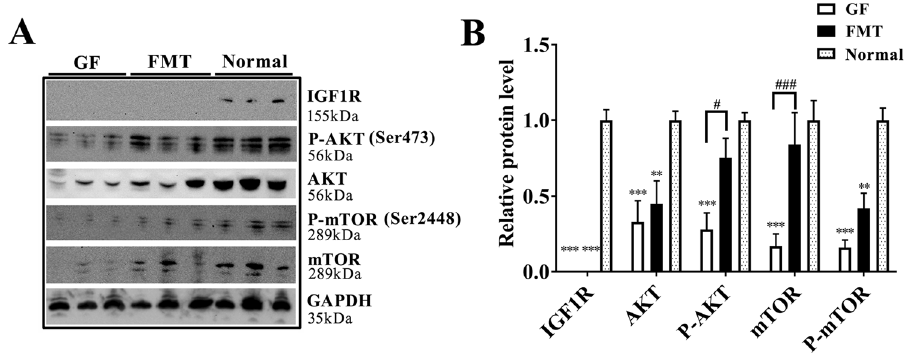
Figure 6. Changes of IGF1/AKT/mTOR pathway in muscle. ( A ) Protein levels of IGF1R, AKT, P-AKT, mTOR and P-mTOR were detected by Western blotting. The full-length blots are presented in Supplementary Fig. 1. ( B ) Relative quantitative analysis of the protein levels. The data are presented as the means ± s.e.m. N = 3, ** P < 0.01, *** P < 0.001 compared to the normal piglets (control). # P < 0.05 and # P < 0.001 between the GF piglets and the FMT piglets. GF piglets germ-free piglets, FMT piglets GF piglets with fecal microbiota